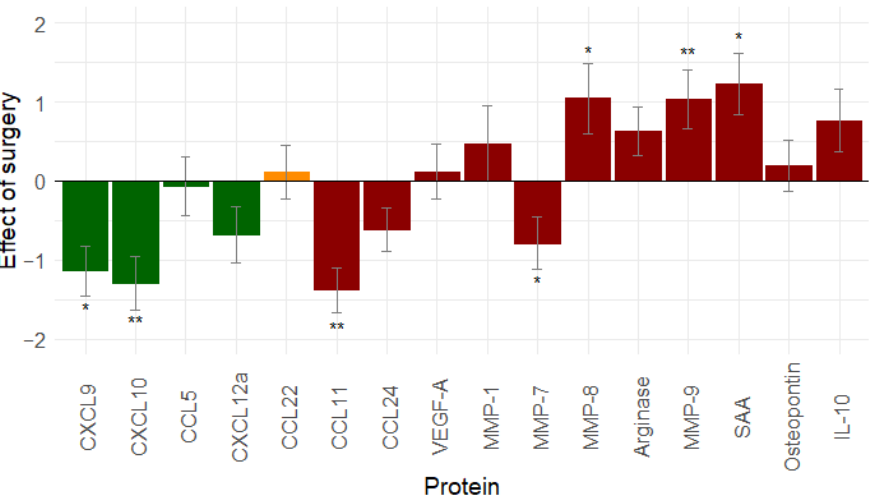
Figure 2. Effect of debulking surgery ( n = 66) on immune related proteins: debulking surgery tends to increase immunosuppression and decrease immunostimulation (similar results are seen when leaving out stage I ovarian cancer patients, see Figure S3). Proteins in green are immune stimulatory factors, proteins in red are immune inhibitory factors, and proteins in orange have a dual function. *: 0.01 ≤ p -value < 0.05; **: p -value < 0.01. Abbreviations: CCL, C-C motif chemokine ligand; CXCL, C-X-C motif chemokine ligand; IL-10, interleukin-10; MMP, matrix metallopeptidase; SAA, serum amyloid A; vascular endothelial growth factor (VEGF).